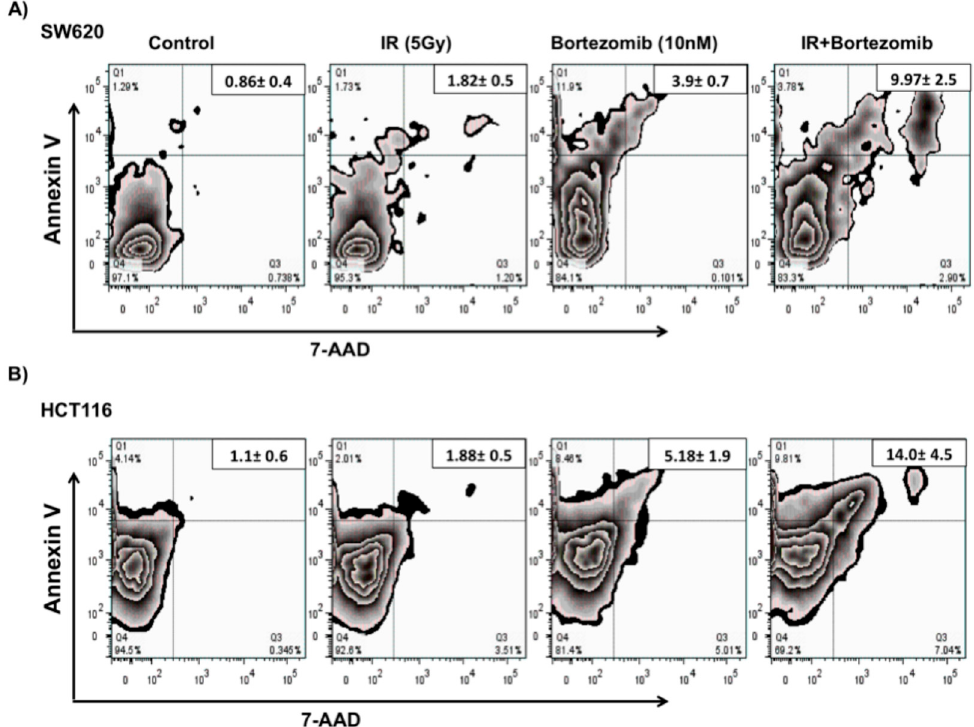
Figure 1. Tumor cells remain viable after a combination treatment of proteasome inhibitor and sub-lethal irradiation. Tumor cells were mock-irradiated (0 Gy) or irradiated with 5 Gy and cultured for 24 h. Following incubation, mock-irradiated or irradiated cells were treated with 10 nM bortezomib and incubated for an additional 24 h. An Annexin V-PE Apoptosis Detection Kit I (BD PharMingen, San Diego, CA, USA) was used for staining; results were quantified by Flow cytometry analysis and were analyzed using FlowJo software (FlowJo LLC, Ashland, OR, USA). Experiment was repeated three times with similar results. The relative increase of dead tumor cells in ( A ) SW620 ( B ) and HTC116 colorectal cancer cells.